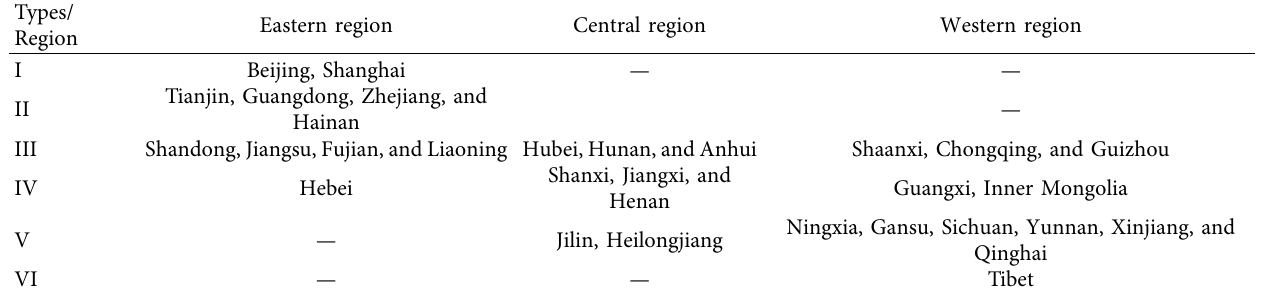
Table 5: Te distribution of the high-quality development level of integrated transport in each province.